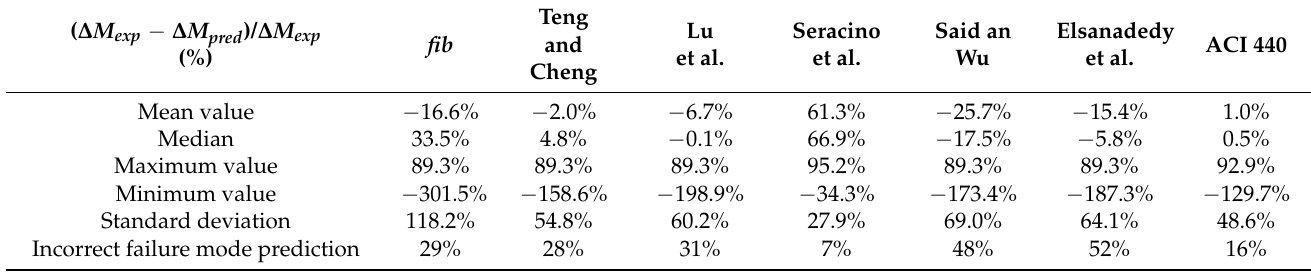
Table 4. Comparison of deviation of predicted results.